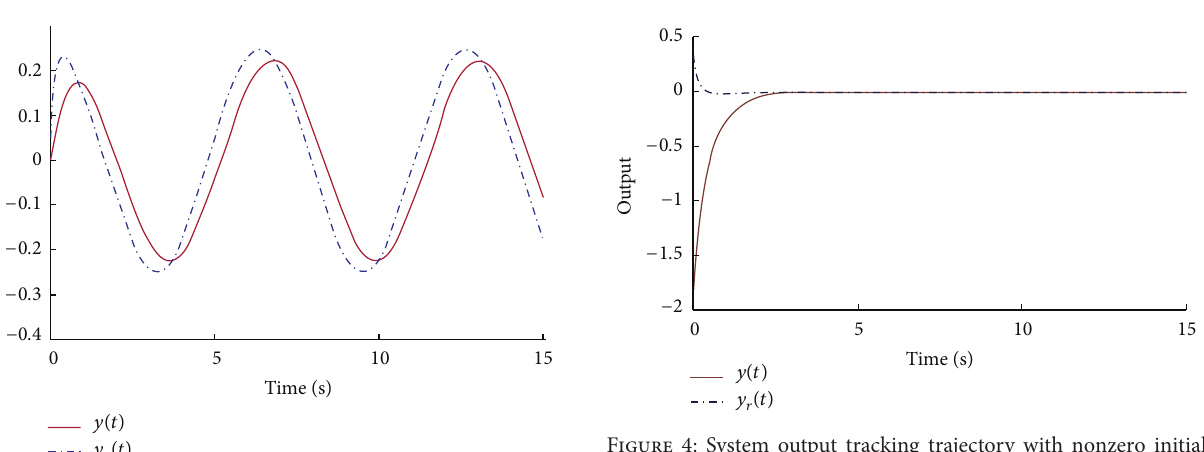
Figure 4: System output tracking trajectory with nonzero initial condition.